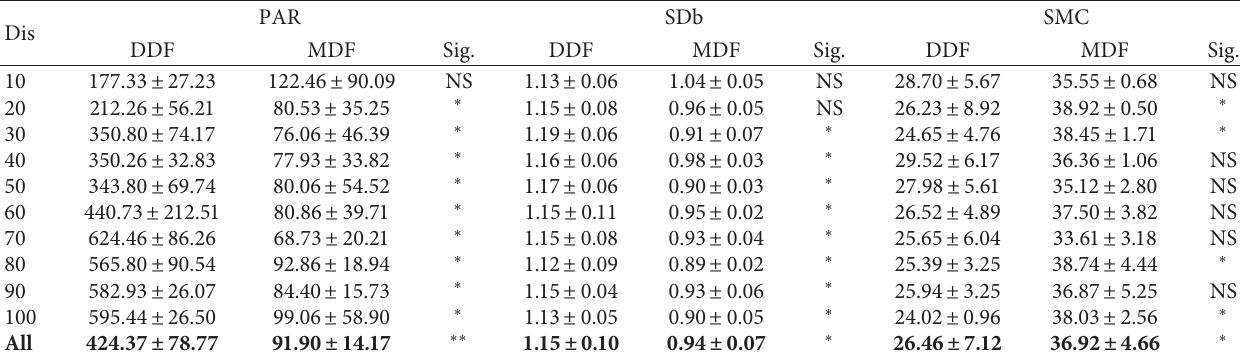
Table 1: Mean ± standard deviation of the physical factors of photosynthetically active radiation (PAR, μ mol photons m − 2 s − 1 ), soil bulk density (SDb, gcm − 3 ), and soil moisture content (SMC, %), as measured in each 10 × 10m plot along the 100m line from the edge to the forest interior